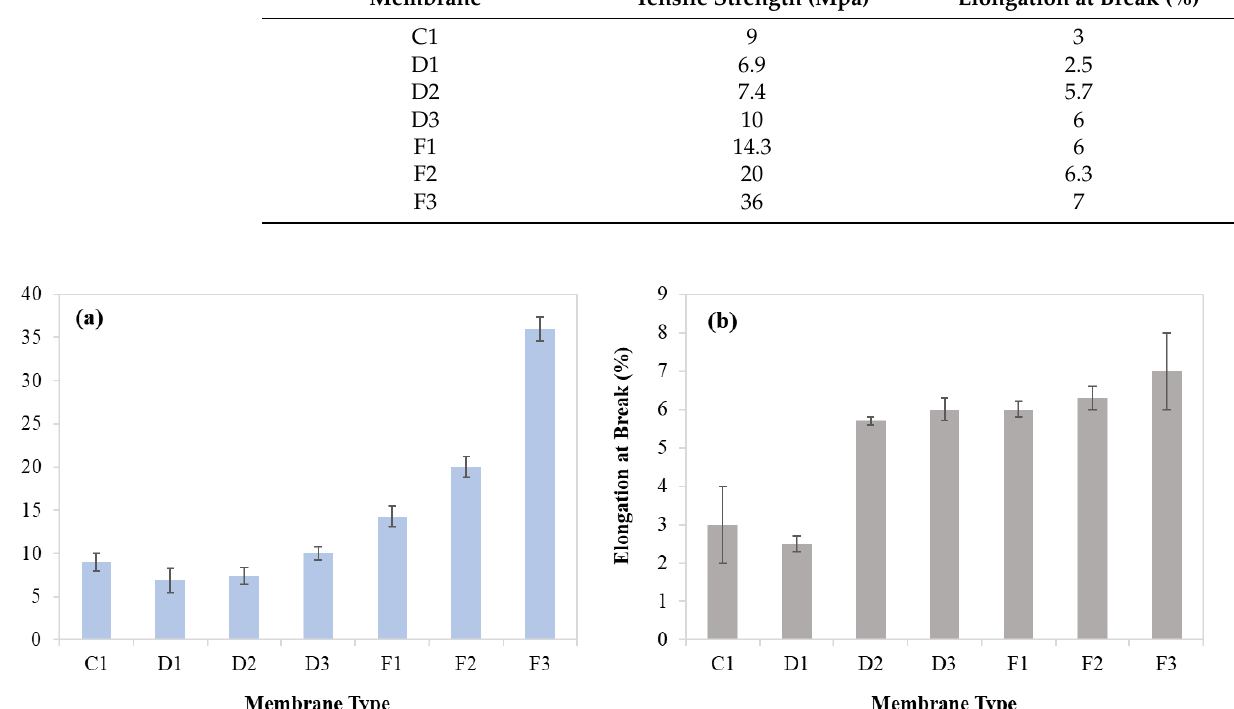
Figure 5. Mechanical properties of the fabricated membranes. ( a ) Tensile strength; ( b ) elongation at break (%).